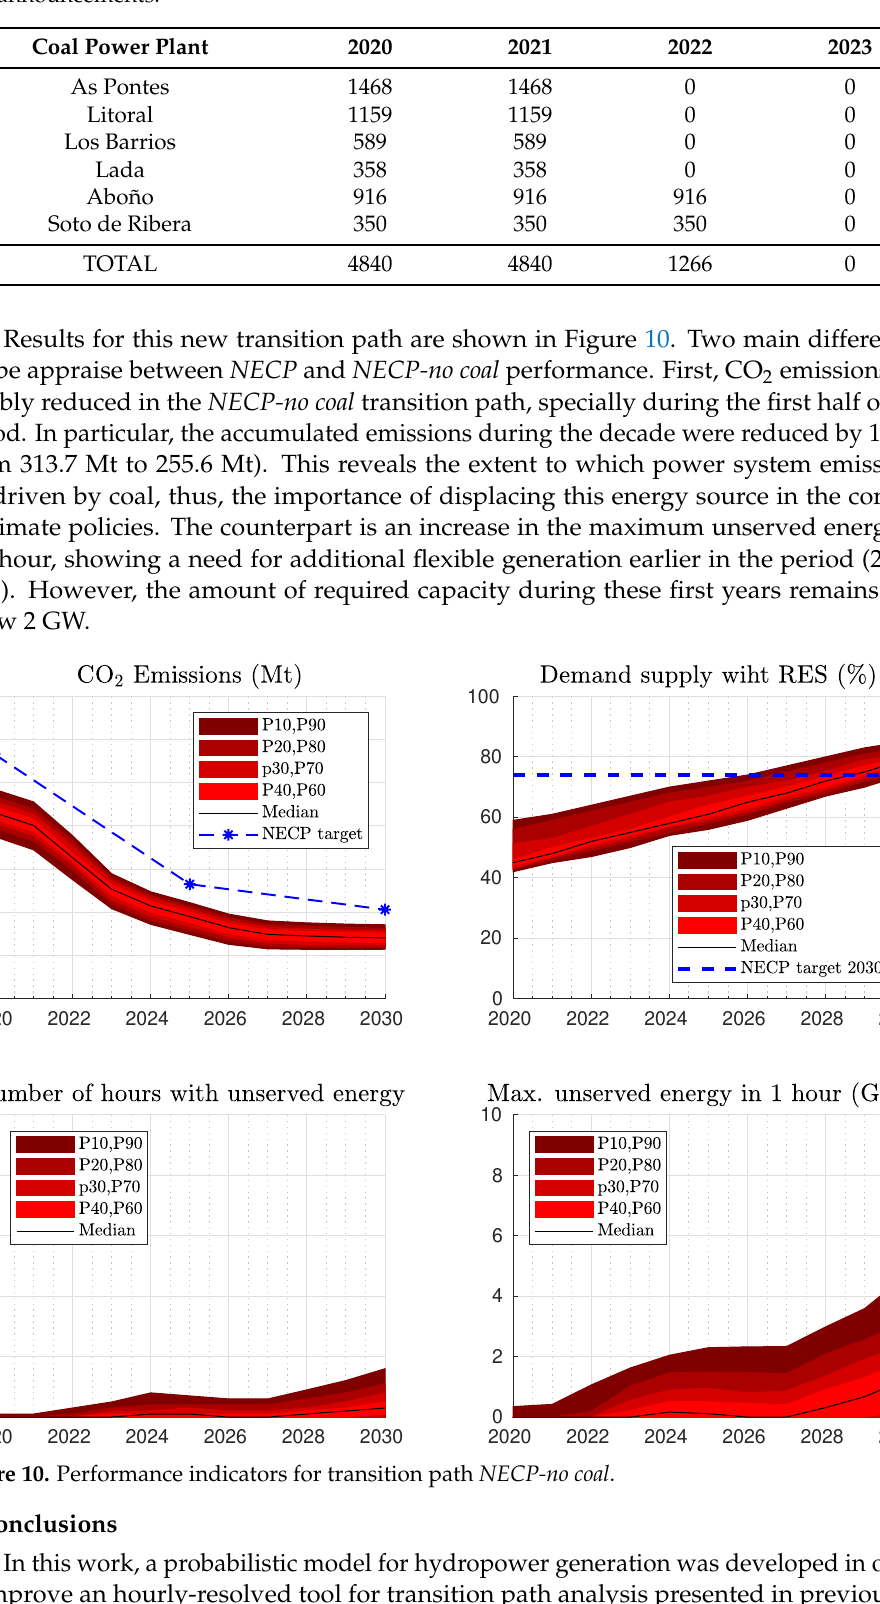
Table 1. Expected installed coal capacity [MW] in peninsular Spain, according to different decommis- sion announcements.